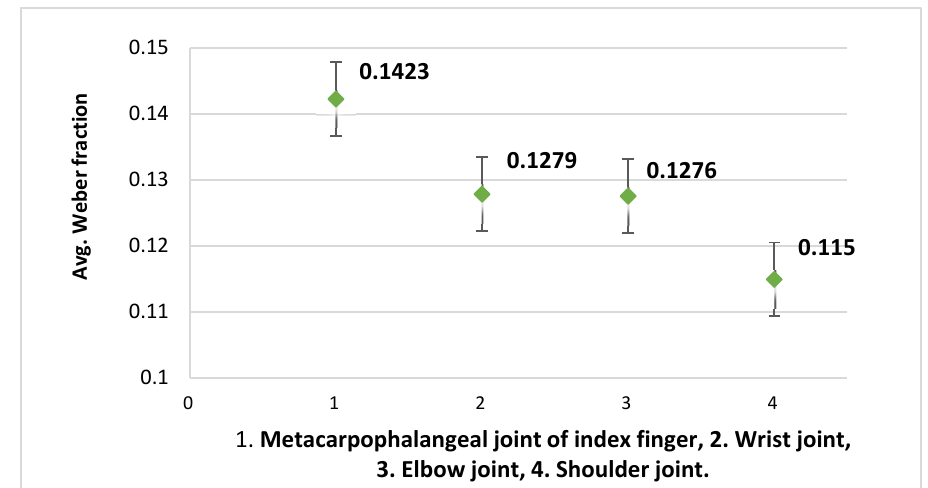
Figure 6. Average Weber fractions (mean ± standard error) of four pivot joints.